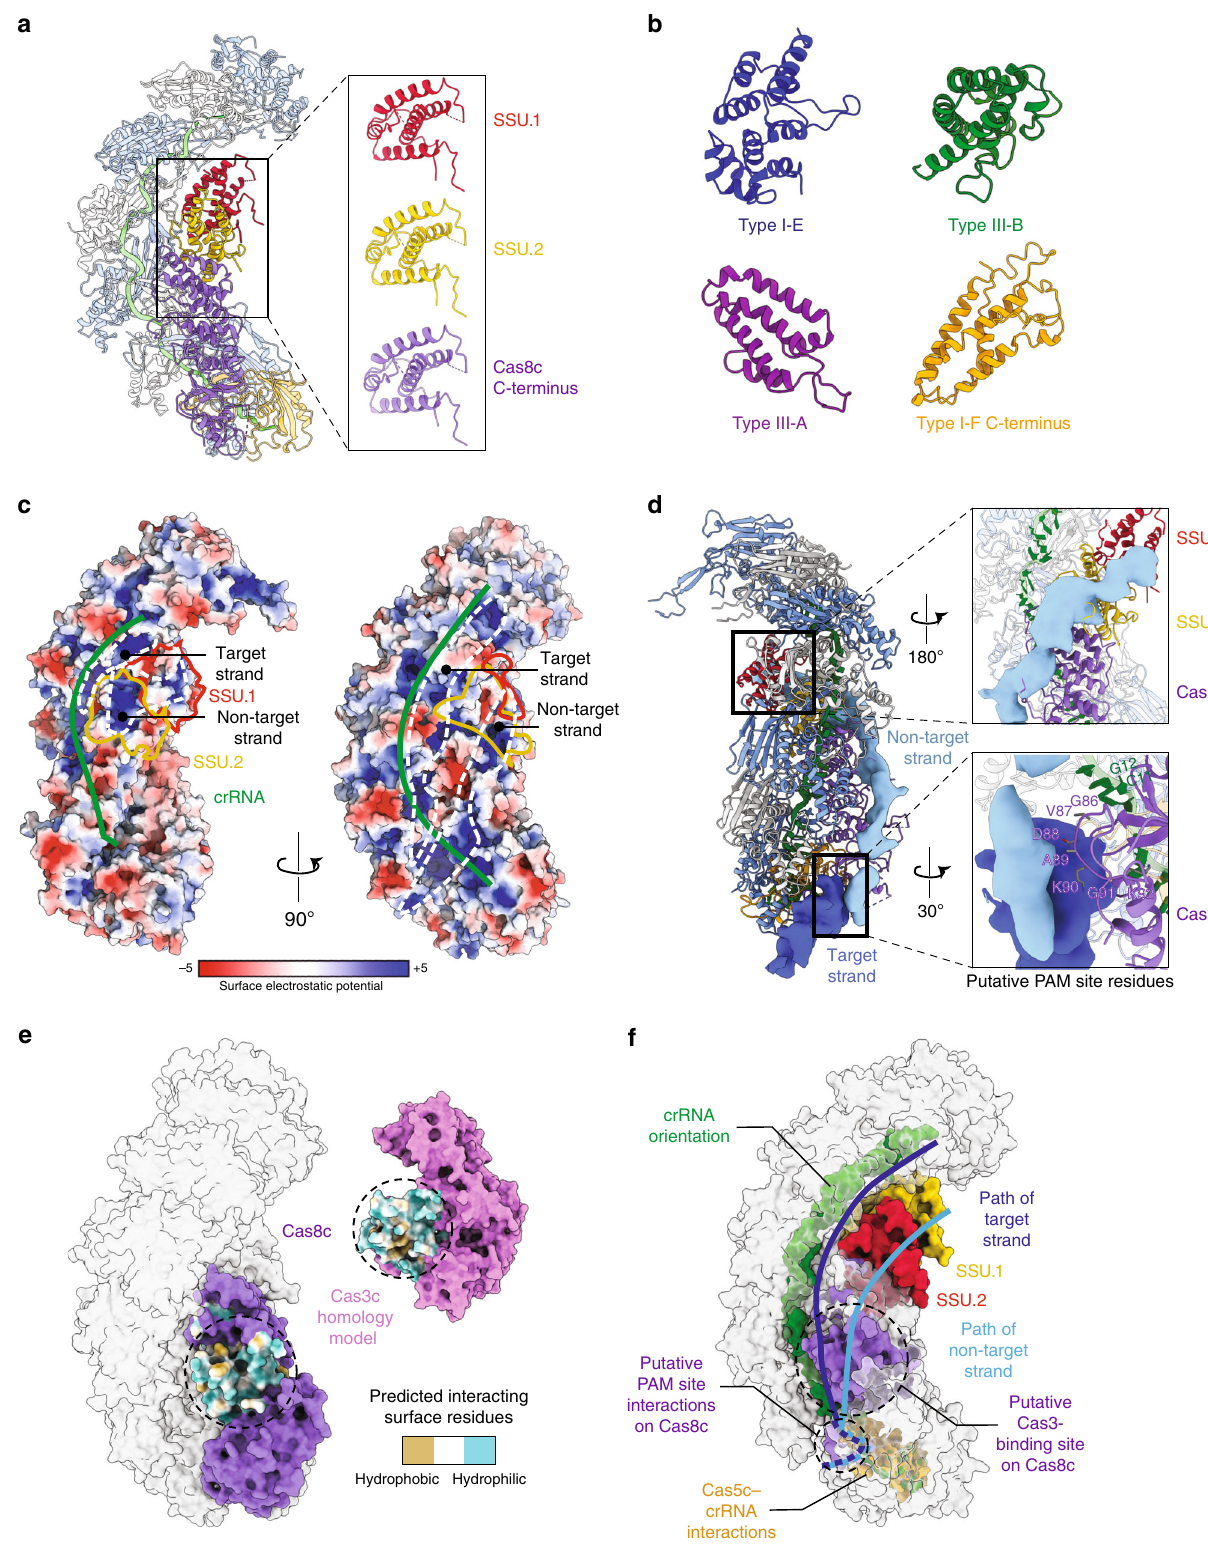
Fig. 2 Non-canonical small subunits (SSU) support R-loop formation. a Cas11 SSU are identical to the C terminus of Cas8c. b Canonical SSU found in type I-E, type III-A, type III-B, and the C-terminal domain of the type I-F large subunit aligned to the type I-C SSU. These SSUs are all helical bundles. c A channel of positively charged surface residues show Cas11c SSU likely accommodate the non-target strand during R-loop formation. d Putative Cas8c (purple) PAM site interacting residues (gray) determined by overlaying the dsDNA density (blue) from previous type I-C cryo-EM maps. e Cas8c (purple) and a homology model Cas3c (pink) show complementary surfaces for Cas3 docking. f Model of type I-C Cascade